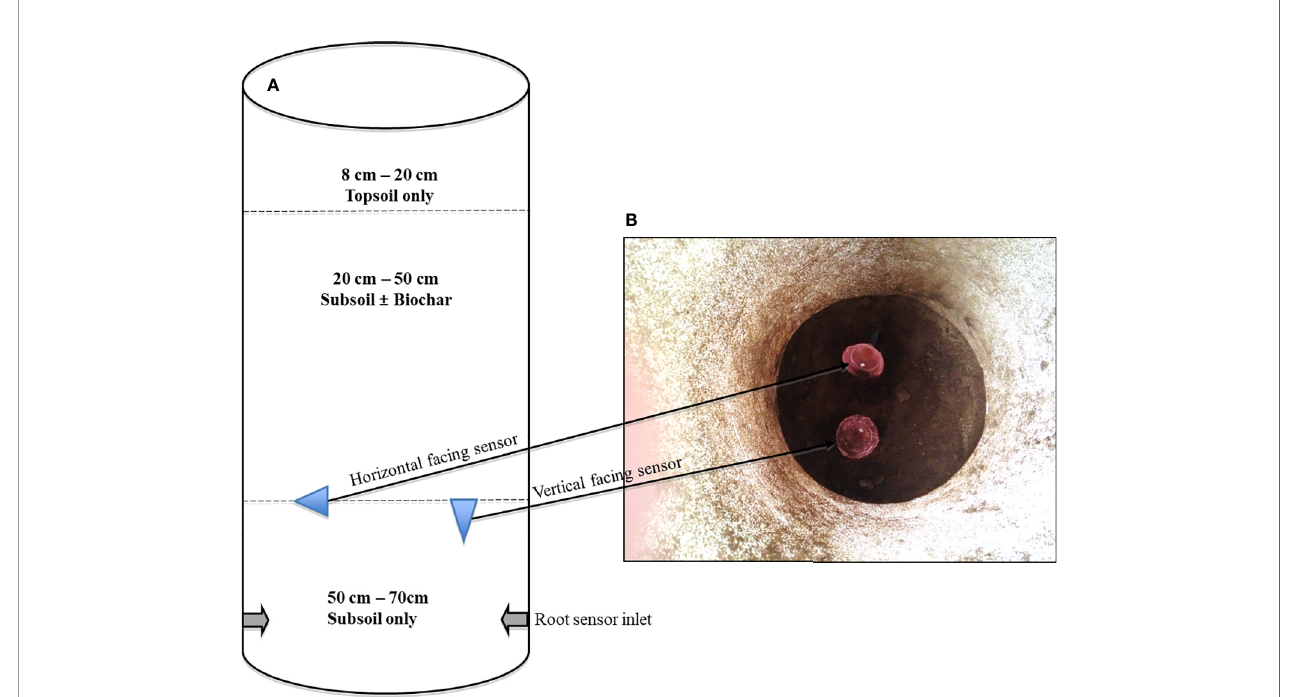
FIGURE 3 | Diagram of the pot set-up (A) and illustration of the sensors positions at 50 cm (B) .